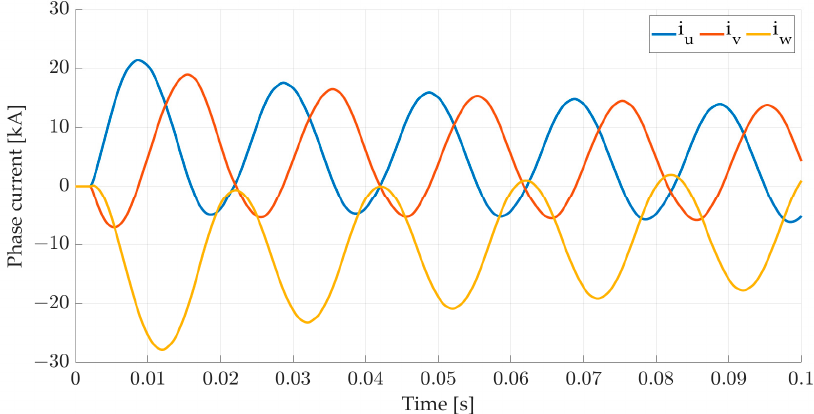
Figure 14. The phase currents obtained by the FEM calculation.